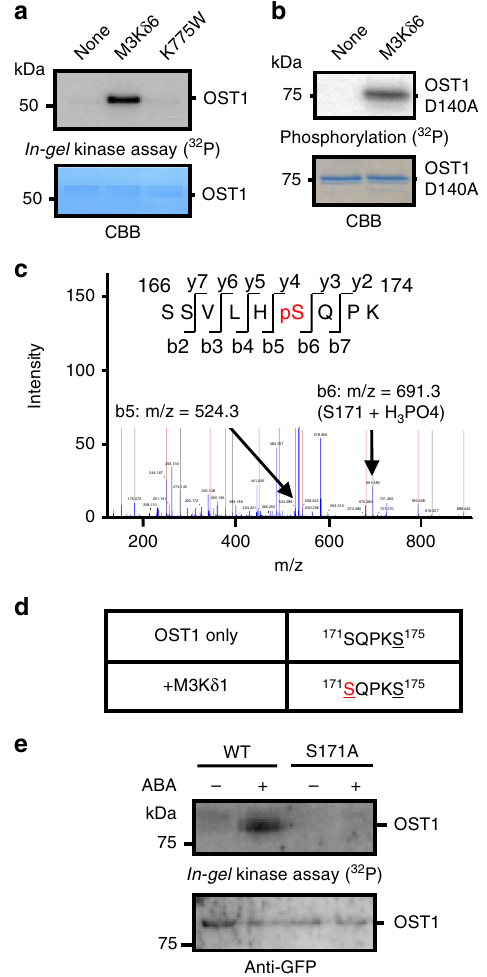
Fig. 2 MAPKK-kinase-induced OST1/SnRK2.6 Ser171 phosphorylation is essential for ABA activation of OST1/SnRK2.6 activation. a The inactive M3K δ 6 kinase domain mutant (K775W) did not reactivate His-OST1/ SnRK2.6 in vitro. b Inactive GST-OST1/SnRK2.6-D140A kinase protein was incubated with M3K δ 6 kinase domain, and in vitro phosphorylation assays were performed with 32 P-ATP. c Recombinant inactive OST1(D140A) and M3K δ 1 kinase domains were incubated with ATP. A mass spectrum of phosphorylated OST1 peptide (SSVLHpSQPK) is shown. pS indicates phosphorylated Ser171 of OST1(D140A). d Phosphorylation at Ser171 was not detectable after in vitro autophosphorylation of OST1/SnRK2.6, but was consistently phosphorylated in the presence of M3K δ 1. e OST1(S171A)-GFP was transiently expressed in Arabidopsis mesophyll cell protoplasts. Protoplasts were incubated with 10 µ M ABA or control buffer for 15 min, and OST1/SnRK2.6 activities were analyzed by in-gel kinase